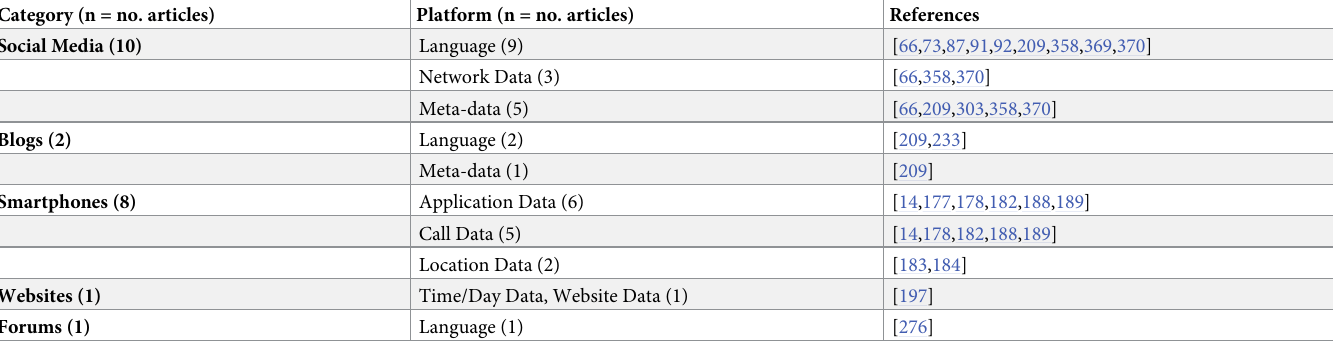
Table 24. Number of articles predicting occupation, with associated predictors and references.